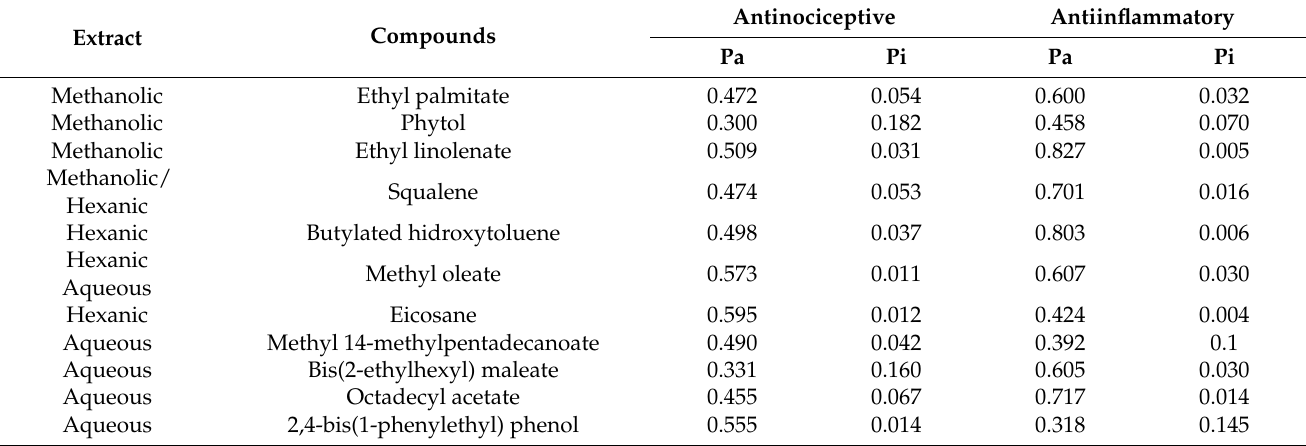
Table 4. PASSonline activities.